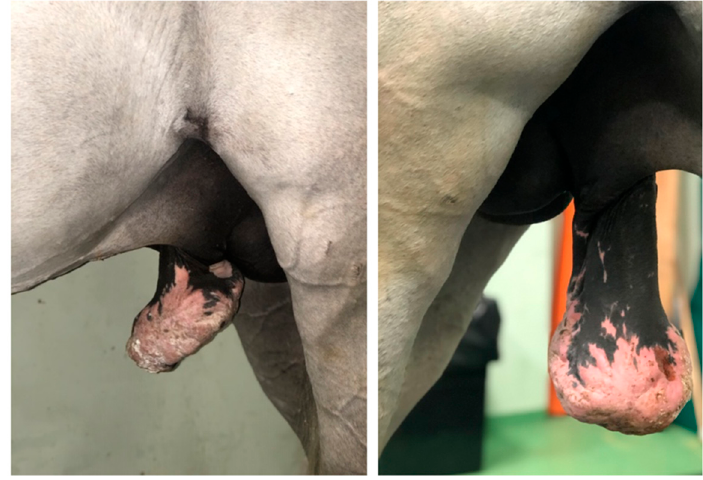
ined, to assess that it was not involved (Figure 5).